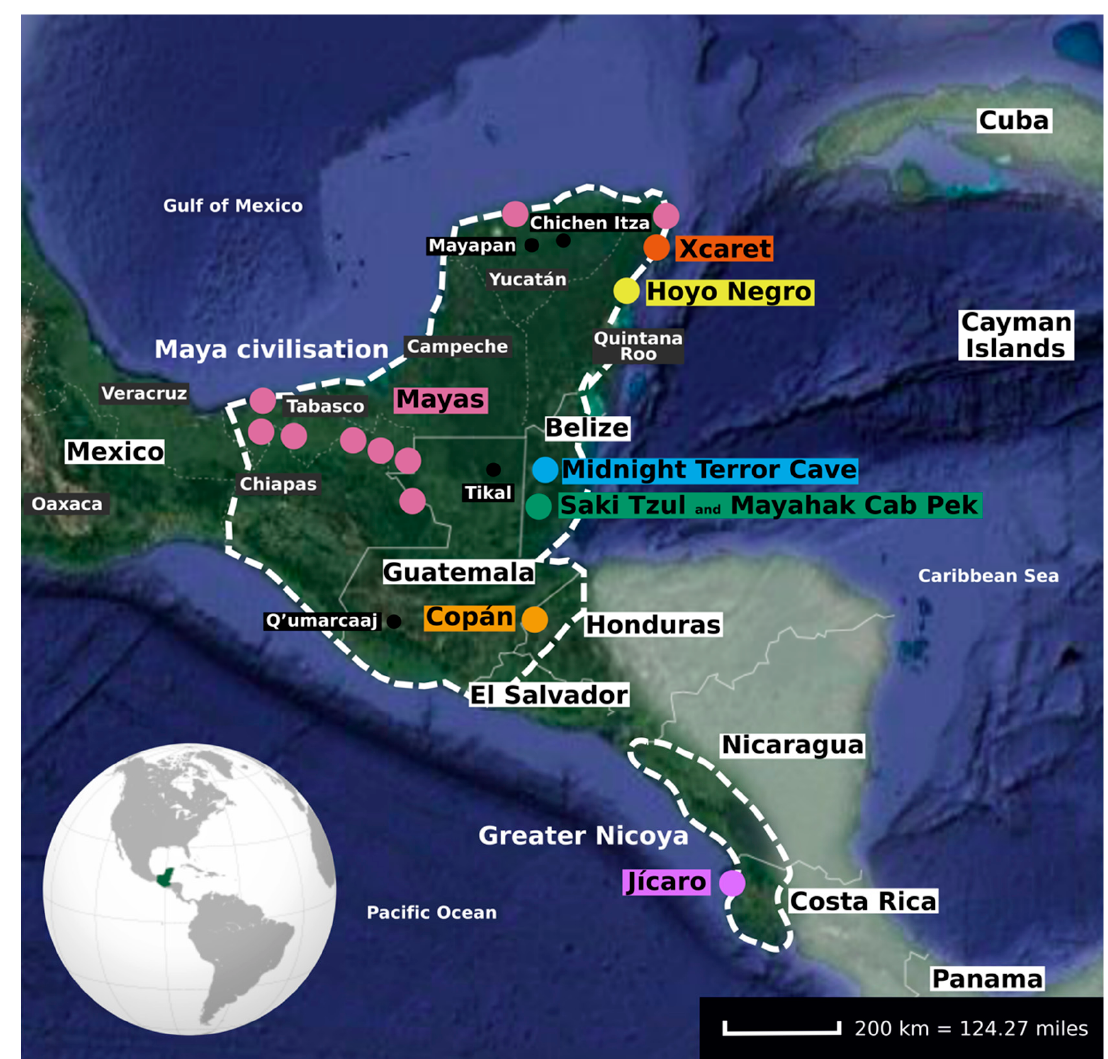
Figure 3. Locations of the archaeological sites in the Yucatán Peninsula and nearby territories, as discussed in the present review. Coloured dots represent the archaeological sites included in each aDNA study. Black dots represent archaeological sites mentioned in the present review with no aDNA data so far. The historical and cultural areas of the Maya civilisation and the Greater Nicoya are within the thick white dashed lines. The shaded area represents regions outside of Mesoamerica. White lines delineate current borders between countries, and thin white dashed lines borders between states. Haplogroup D1 was actually found in two genetically related individuals (~5300 BCE) from the archaeological site of Saki Tzul in the Maya Mountains (Belize) [3]. Another individual (~7300 BCE) from the same region, found in the archaeological site of Mayahak Cab Pek (Belize), carried the native haplogroup D4h3a [3]. The genomic data of these individuals from the Maya Mountains revealed that from the region near Belize [3]. This result suggests that they formed part of a homogenous population ancestry of Central and South